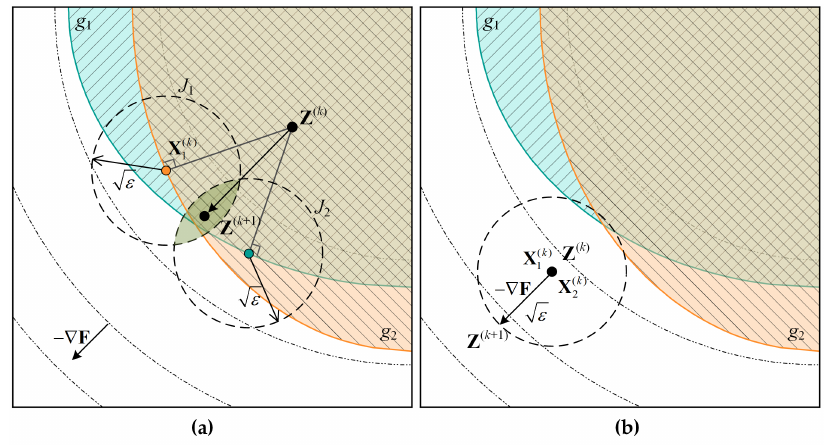
Figure 8. Schematic of CO method process ( a ) Initial point in the infeasible zone; ( b ) Initial point in the feasible